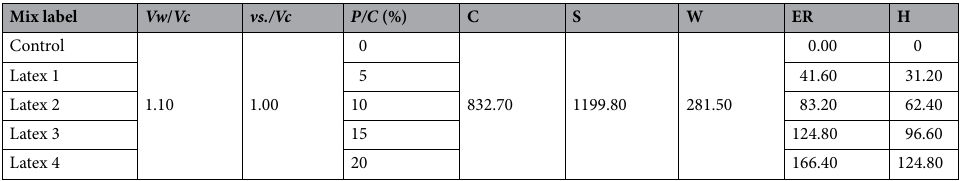
Table 2. Mix proportions for epoxy latex-modified mortars (kg/m 3 ). C, S, W, ER, and H are the quantities of cement, quartz sand, water, dry epoxy resin, and dry hardener,